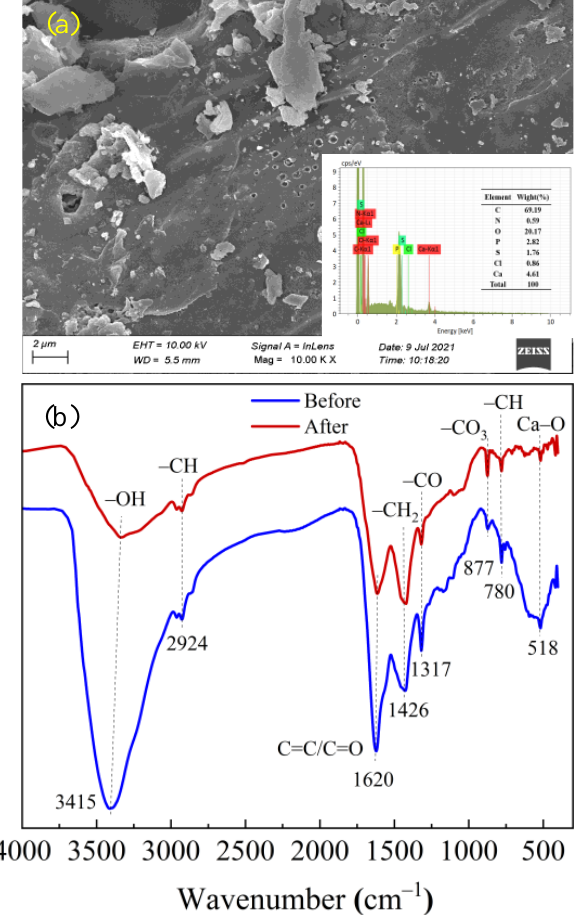
Figure 4. Characterization of WHCBC after adsorption: ( a ) SEM – EDS of WHCBC after adsorption; ( b ) FTIR spectrum of WHCBC after adsorption.